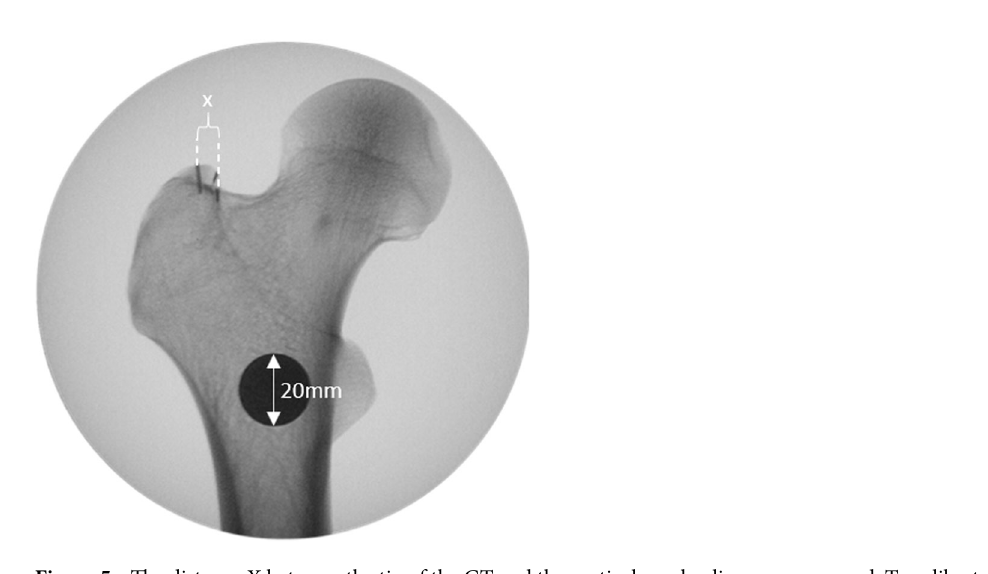
Figure 5. The distance X between the tip of the GT and the cortical overlap line was measured. To calibrate the measurements a coin with a known diameter of 20 mm was place directly on the femur while obtaining the